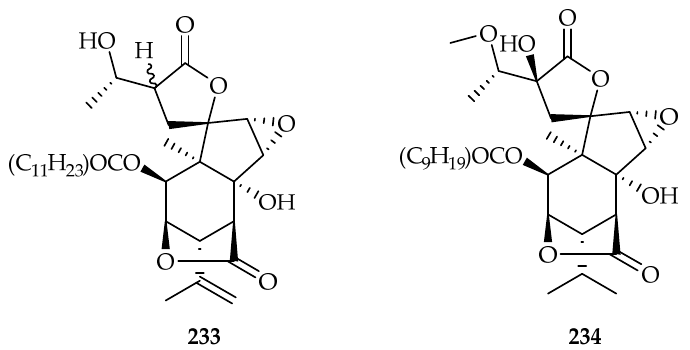
Figure 92. Structures of austrobuxusin F 233 [145] and austrobuxusin L 234 [145]. Two new dinorditerpene dilactones, 2β-hydroxymakilactone A 235 and 3β-hy- droxymakilactone A 236 , were isolated from the roots of Podocarpus macrophyllus (Podo- carpaceae) (Figure 93). The structures of 235 and 236 were elucidated by spectroscopic analysis, including 1D NMR, 2D NMR, and HR-ESI-MS data. Compounds 235 and 236 were evaluated for their cytotoxicities against the AGS, HeLa, MDA-MB-231, HepG-2, and PANC-1 cell lines, using cisplatin as a positive control. The 2β-Hydroxymakilactone A 235 exhibited significant activities, with IC 50 values of 0.38, 0.87, and 4.23 μM against AGS, HeLa, and MDA-MB-231 cells, respectively, while 3β-hydroxymakilactone A 236 exhib- ited obvious activities, with IC 50 values ranging from 11.61 to 0.88 μM against all the five cell lines [146].